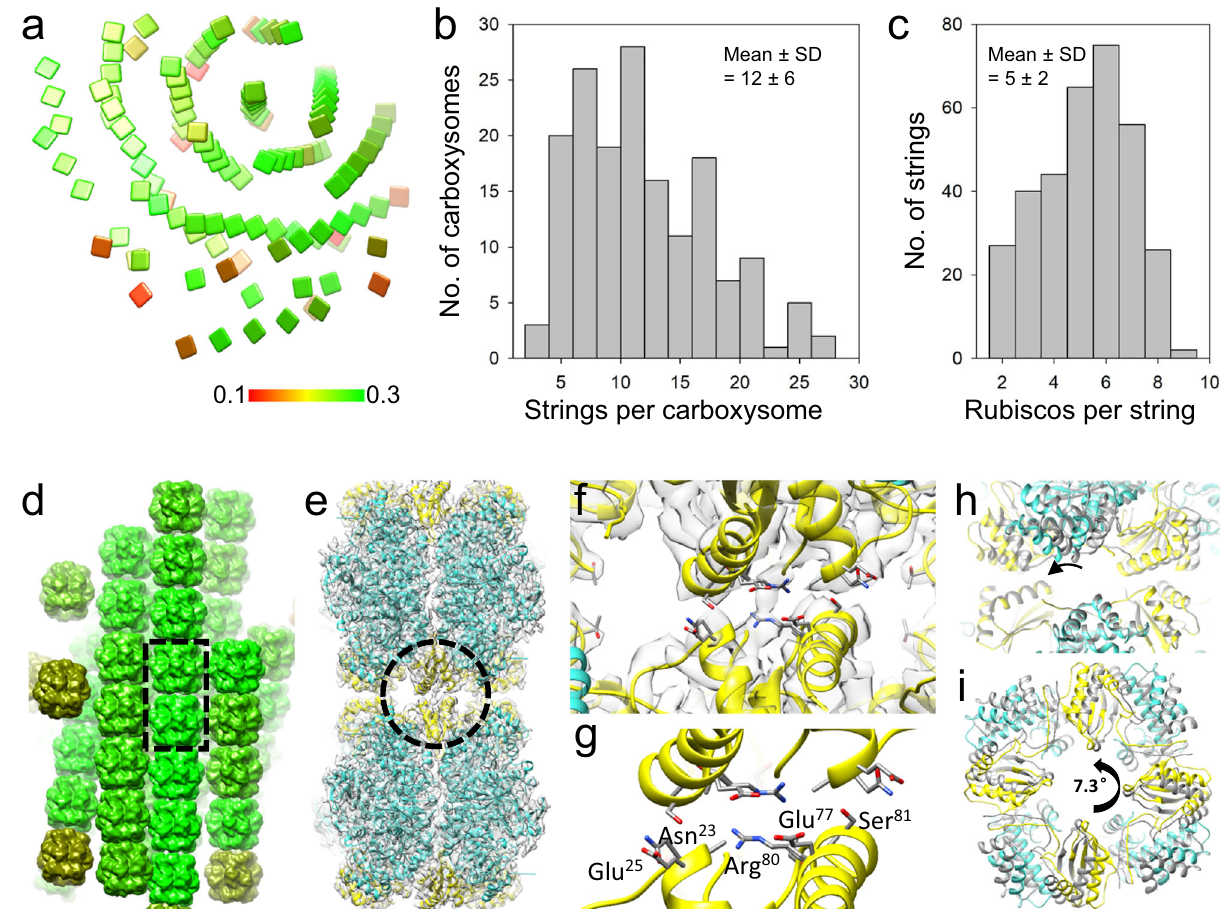
Fig. 3 | Spiral string assembly of Rubisco within native Halo α -carboxysomes. a The positionand orientation ofdi-Rubiscomapped back to the tomogramofthe Halo carboxysome, shown in a square plate as in Fig. 1b. b Histogram of Rubisco string number in Halo carboxysomes ( n =167 carboxysomes). c Histogram of Rubisco string length in Halo carboxysomes ( n =335 strings). d Rubisco sub- volumes are mapped back to Halo carboxysome spiral strings. The dashed rec- tangle encloses a Rubisco dimer. e Cryo-ET STA structure of the Rubisco dimer at 4.1Åresolution, overlapped withthe fi ttedatomicmodel. f , g Detailedviews ofthe